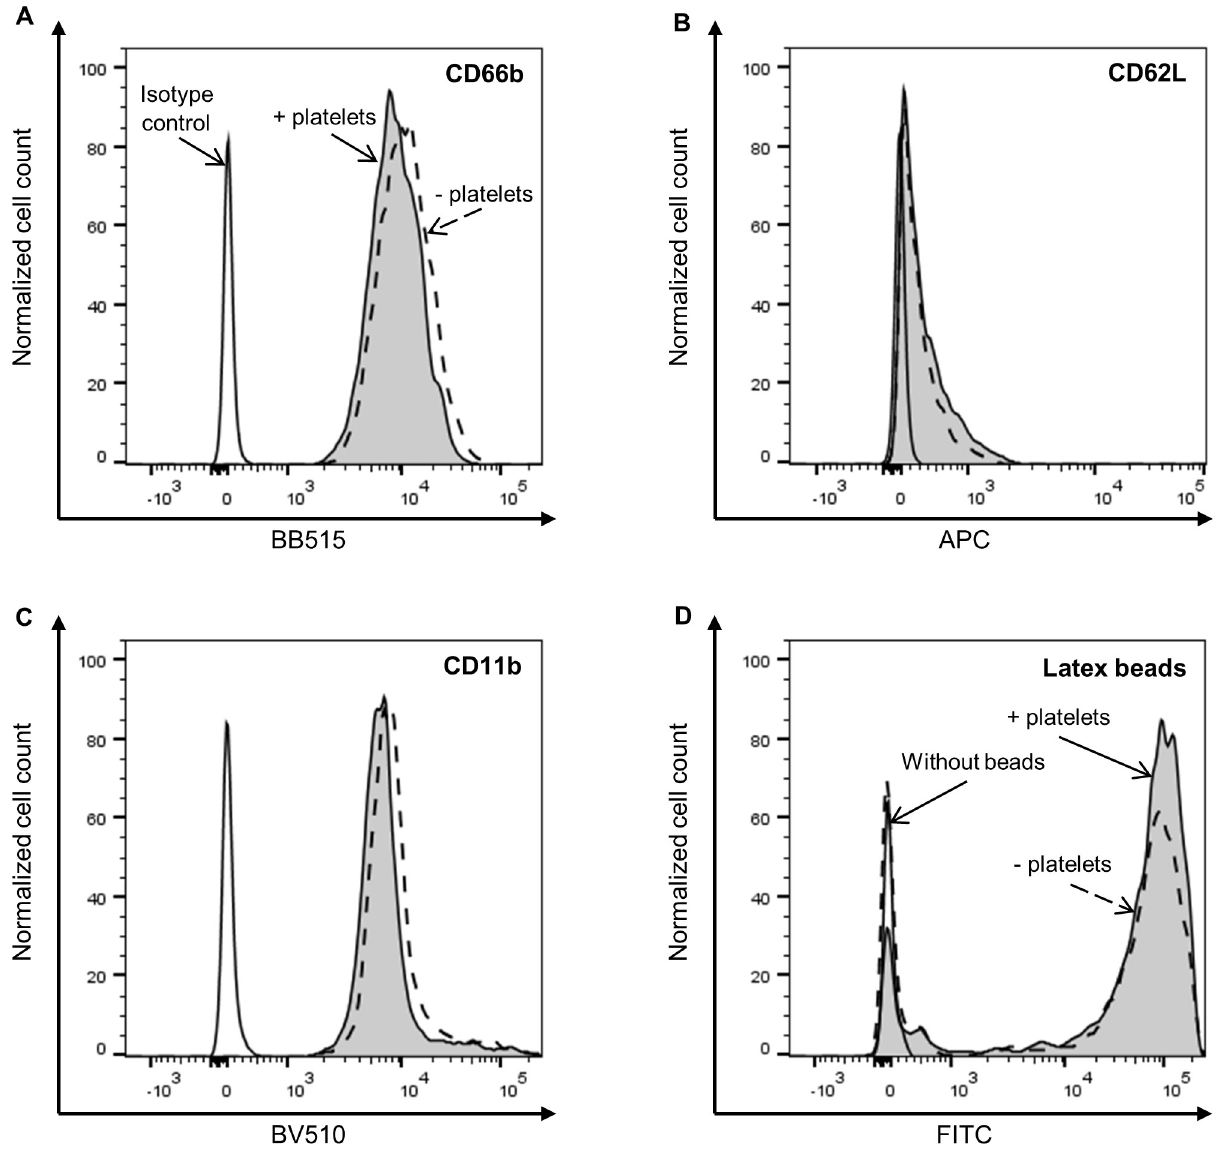
Fig 2. Platelets modulate neutrophil responses to in vitro TLR stimulation. Representative plots of neutrophil CD66b expression (A), CD62L expression (B), CD11b expression (C), and neutrophil phagocytic activity (D) are shown for neutrophils stimulated with 100 ng/mL FSL-1, with and without the addition of